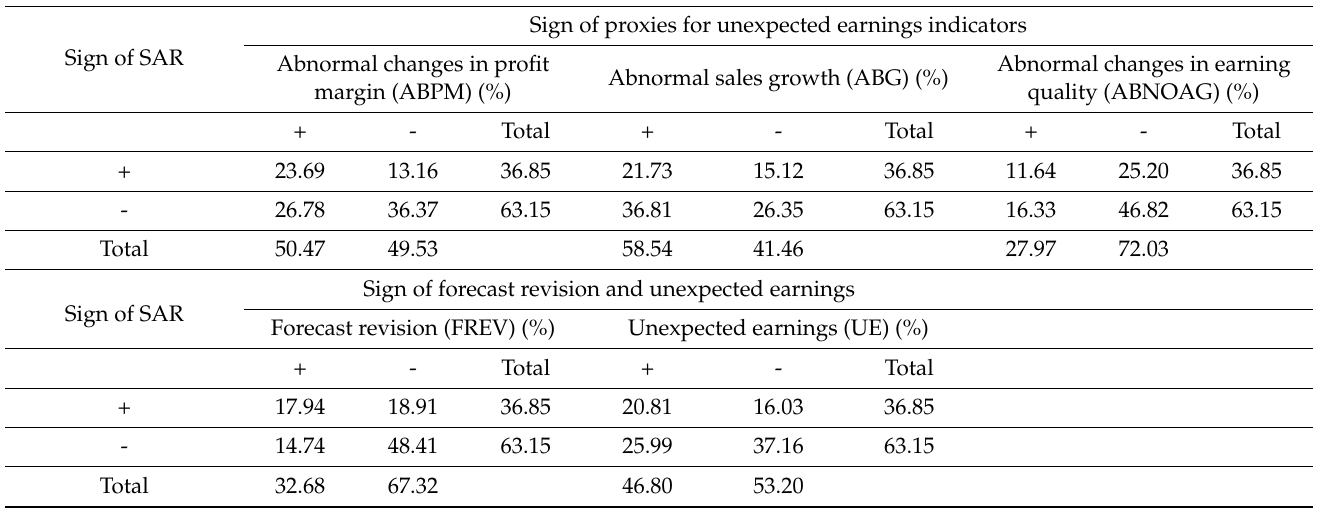
Panel C: Contingent table of the signs of the one-year-ahead decile size-adjusted returns vs. unexpected earnings Indicators, b shown as the percentage out of the total sample